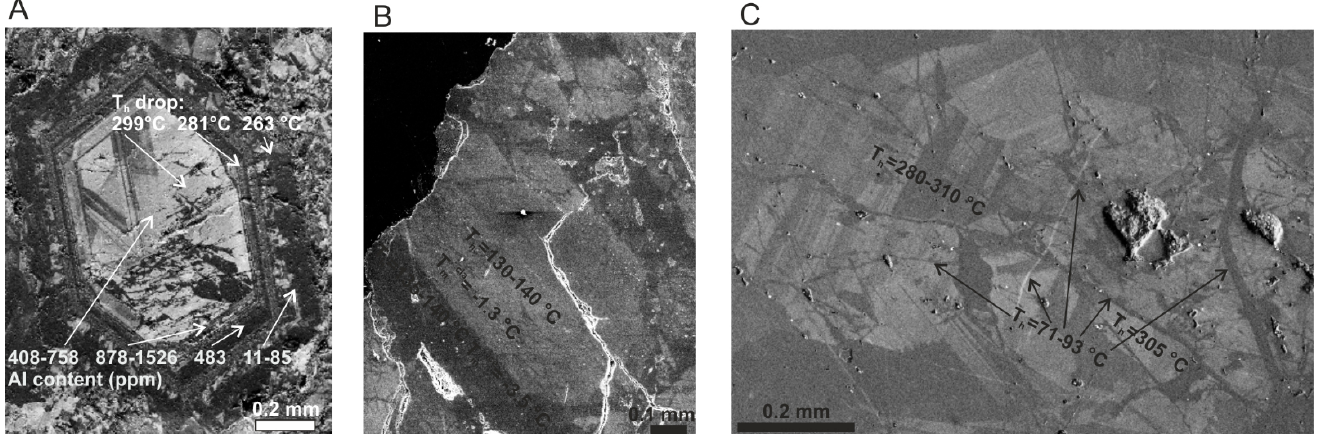
Figure 10. SEM-CL images of various quartz grains with interpreted fluid inclusion microthermometry data. ( A ) T h drop from the core to the rim of a single crystal (Qtz 1) contributed to wide T h ranges. Correlation between Al content and SEM-CL characteristics is also observable (Boccassuolo). ( B ) Methane clathrate was the last phase to melt in the CL-bright core of the quartz grain while ice melting (at a markedly lower temperature) was observed in the CL-dark outer growth zone (Bargone). ( C ) T h drop from inner to outer growth zones within a Qtz 1 grain was observable. Besides high T h primary inclusions (found in CL-bright areas), the spongy core contained many CL-dark microfractures with low T h secondary inclusions (Vigonzano).